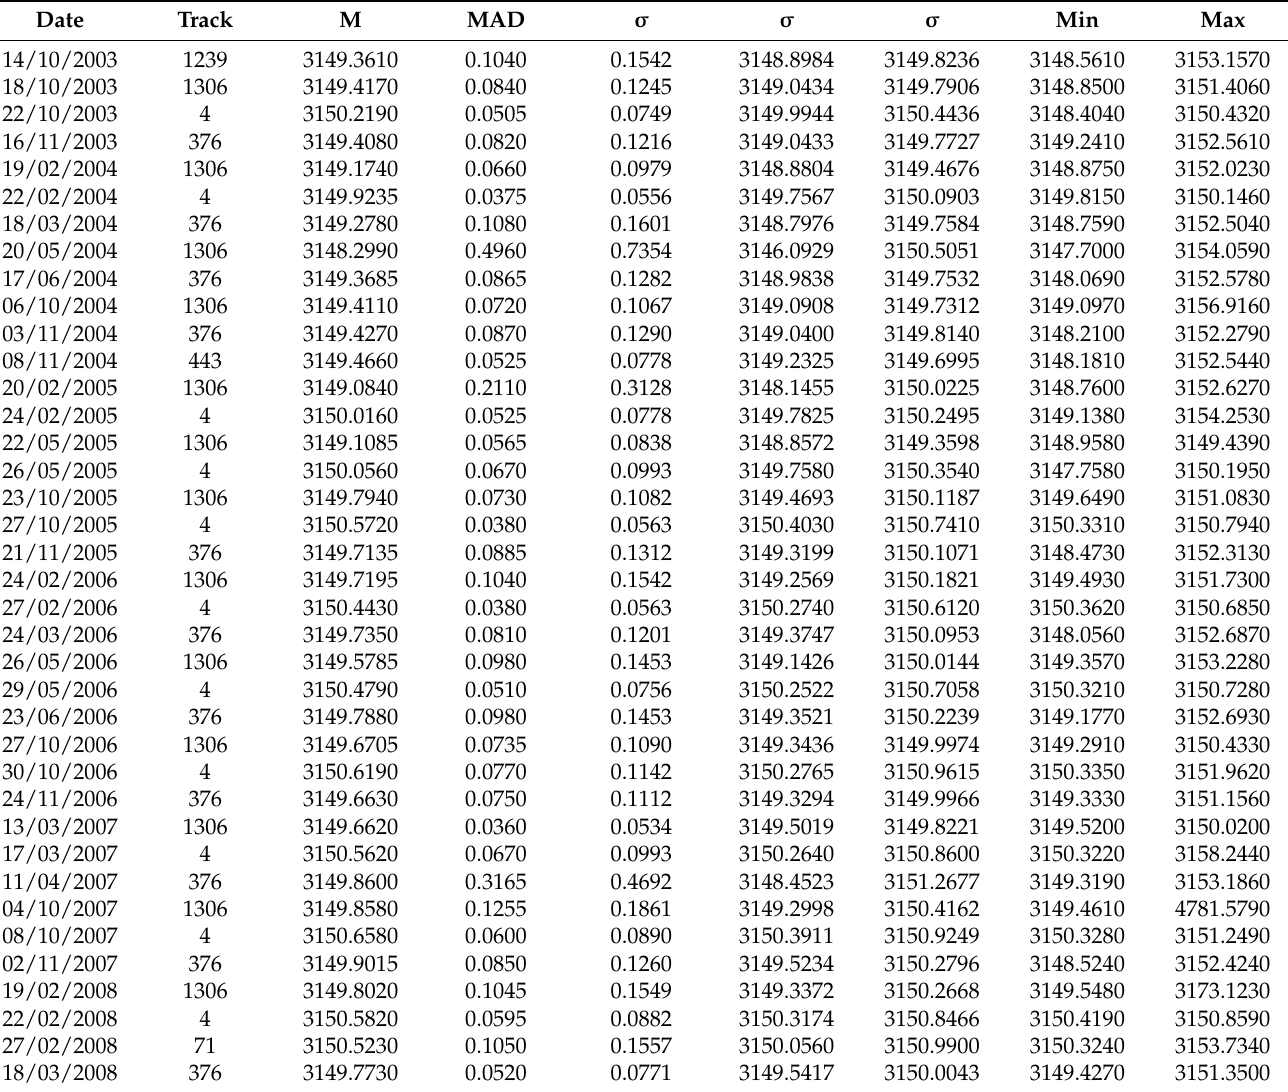
Table A1. The parameters of the MAD outlier method for the corresponding dates of